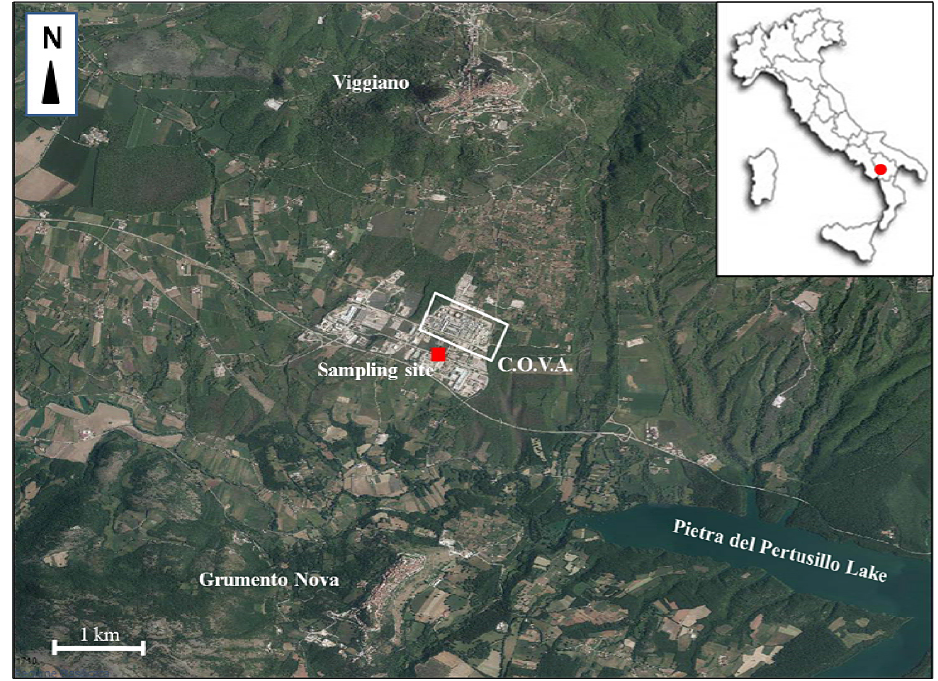
Figure 1. COVA plant and PM sampling site location. Copyright AGEA – Orthophoto